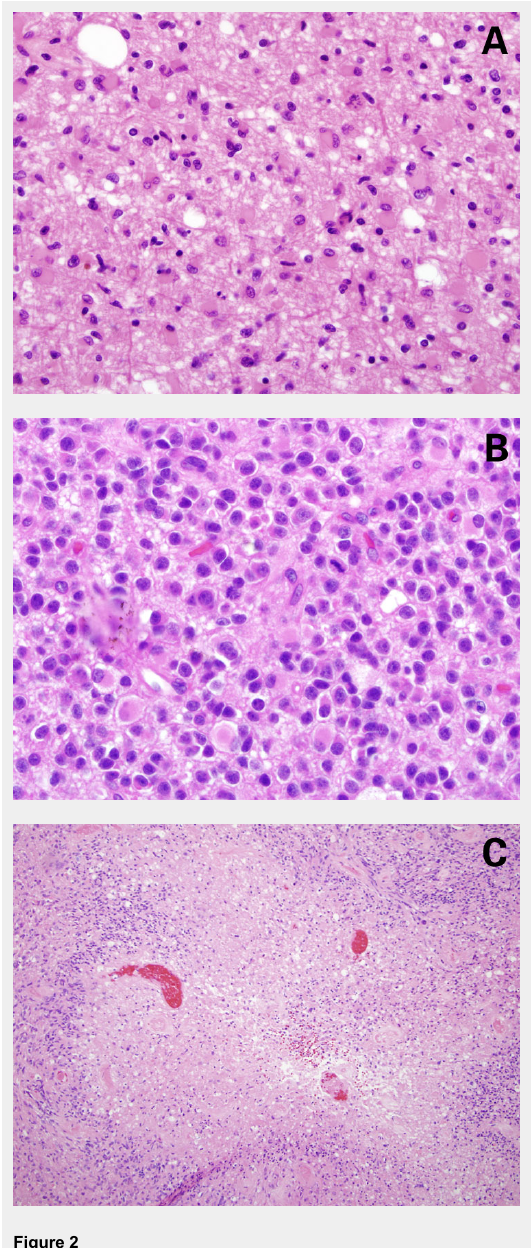
Morphological characteristics of malignant gliomas: A = anaplastic astrocytoma, B = anaplastic oligodendroglioma, C = glioblastoma (for details, see text) (courtesy: E. Rushing, Zurich). A shows a moderately cellular astrocytic tumour with mitoses and pleomorphic nuclei. B shows closely apposed tumour cells with round nuclei and perinuclear halos accompanied by mitoses typical of an anaplastic oligodendroglioma. C shows areas of necrosis and perinecrotic palisade formation characteristic of glioblastoma.